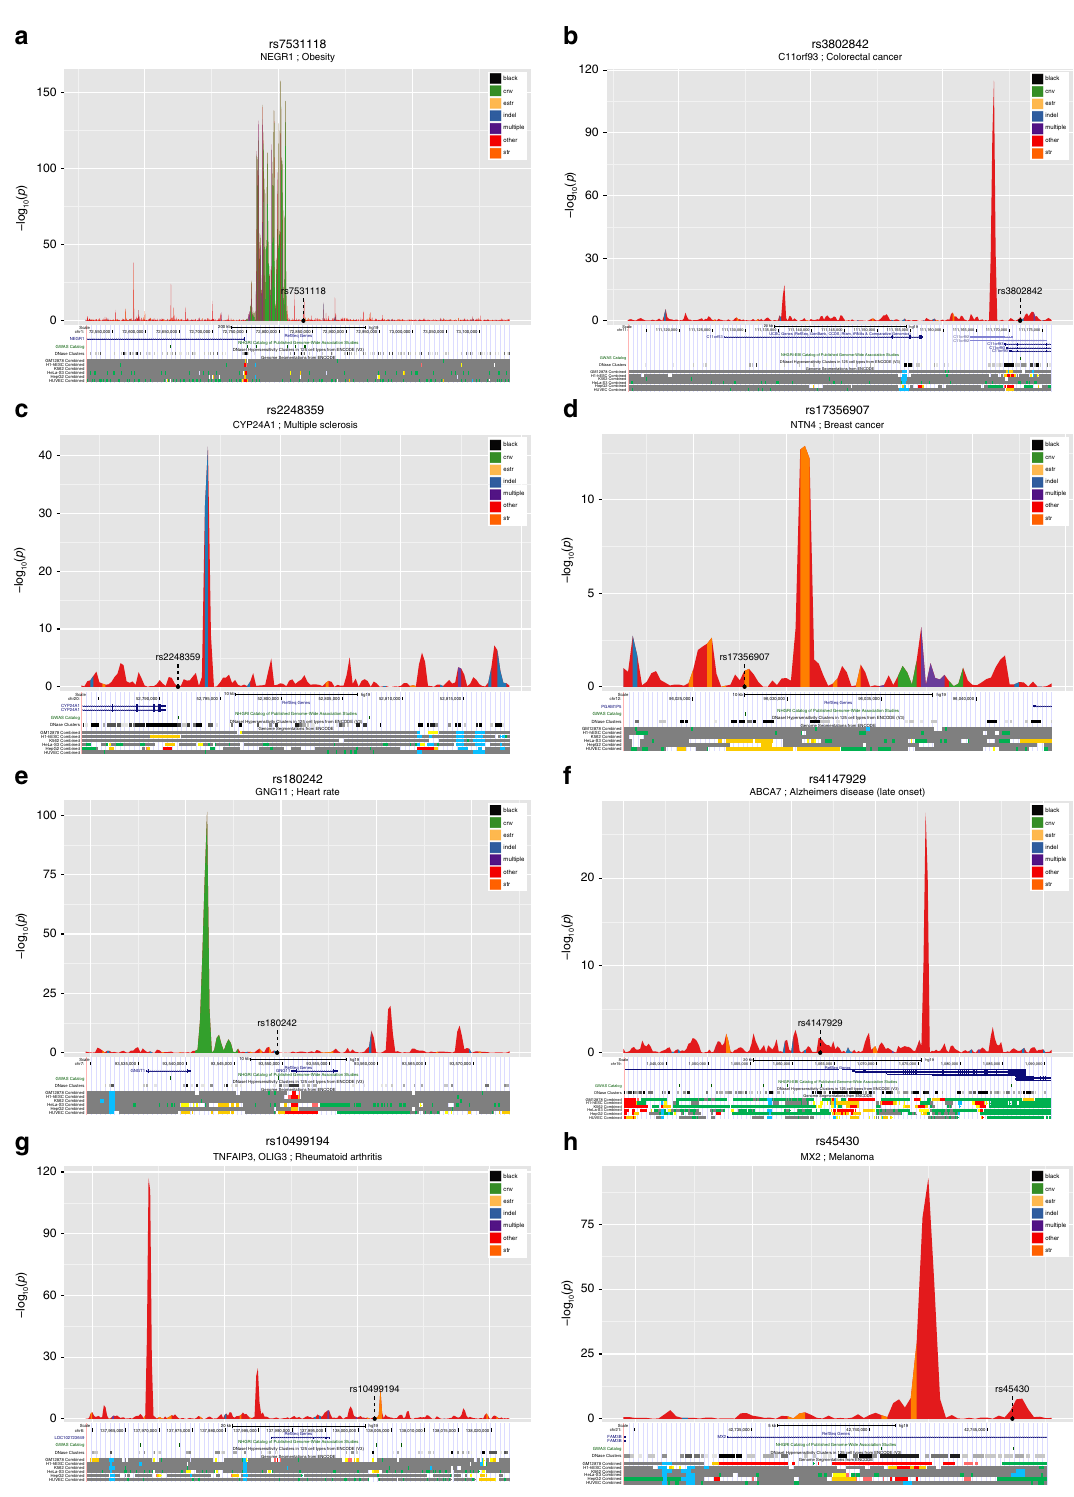
Fig. 3 HSM peaks within selected GWAS LD block regions. The y -axis denotes the -log 10 ( p value) of the differential DNA methylation according to the genotypic status for the index (GWAS associated) SNP and the x -axis is the genomic position (in base-pairs) along the LD block. The HSM peaks are coloured in accordance with the class of polymorphisms they overlap with, i.e. copy number variant (CNV, Green), short tandem repeats (STR, Orange), expression-associated short tandem repeats (e-STR, Fawn), insertion – deletions (Indels, Blue), multiple variant overlaps (Purple) and other category (Red). a NEGR1 obesity locus; b intergenic colorectal cancer; c CYP24A1 multiple sclerosis; d NTN4 breast cancer; e GNG11 heart rate; f ABCA7 Alzheimer ’ s disease; g TNFAIP3 rheumatoid arthritis and h MX2 melanoma. Underneath is the UCSC browser track for location with RefSeq genes, GWAS catalogue SNPs, DNase-I hypersensitivity clusters and combined chromatin segmentation tracks. The segmentation tracks are in standard colours (Red: Promoter; Light Red: Promoter Flanking; Orange: Enhancer; Yellow: Weak Enhancer; Blue: CTCF element; Dark Green: Transcribed Region; Grey: Repressed/Low